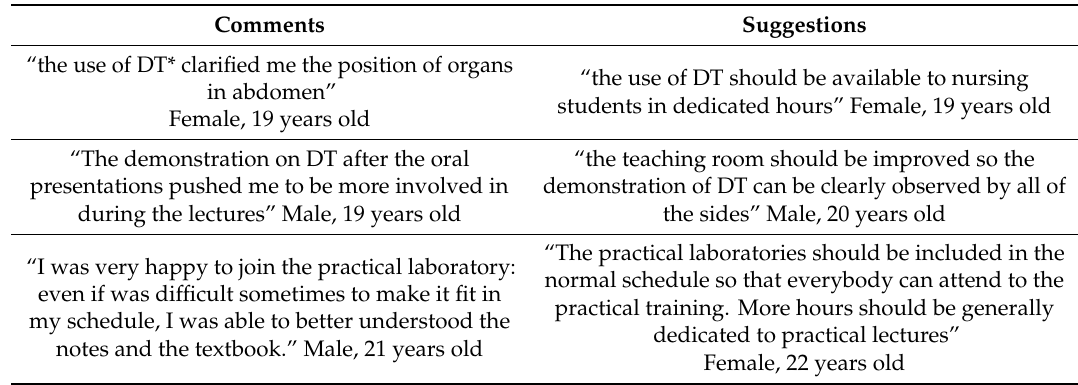
Table 1. Quotation of the most representative comments and suggestions. * DT: Dissection